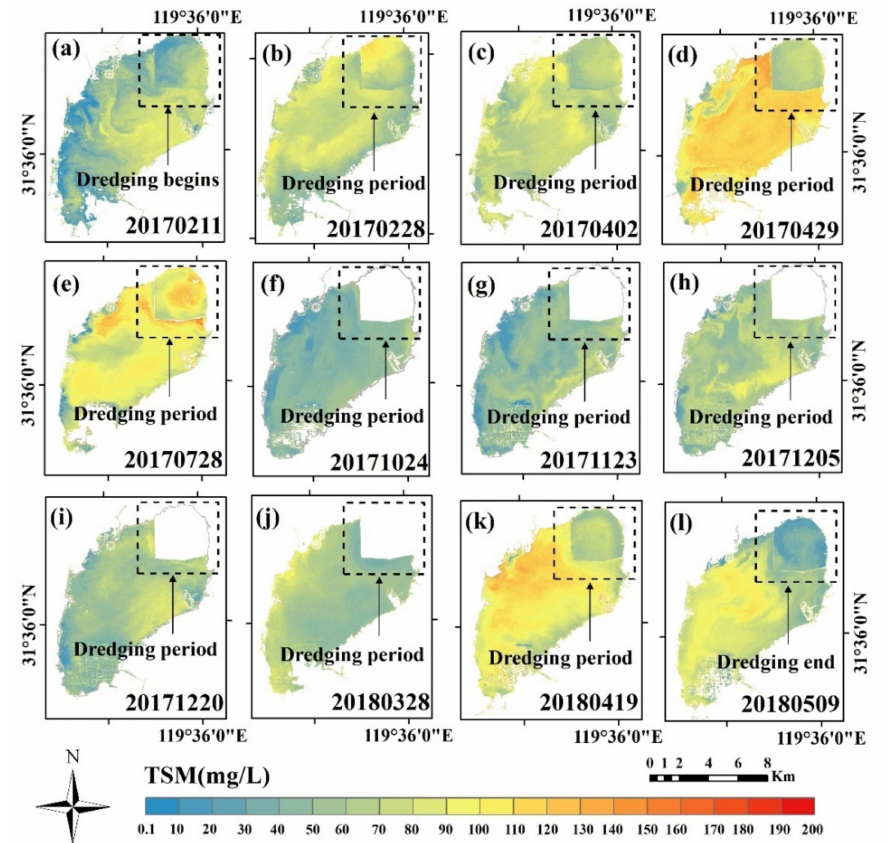
Figure 8. Sentinel-2 images showing temporal changes in the spatial distribution of TSM concentra- tion in Changdang Lake during the first stage of ecological dredging. ( a – e ) indicates that construction cofferdams are being built in the northeast corner of Changdang Lake and may start pumping; ( f – j ) indicates the process of removing silt after pumping, and the white space indicates the period when there is no water; ( k , l ) indicates the process of re-injecting water into the northeast corner after silt removal is